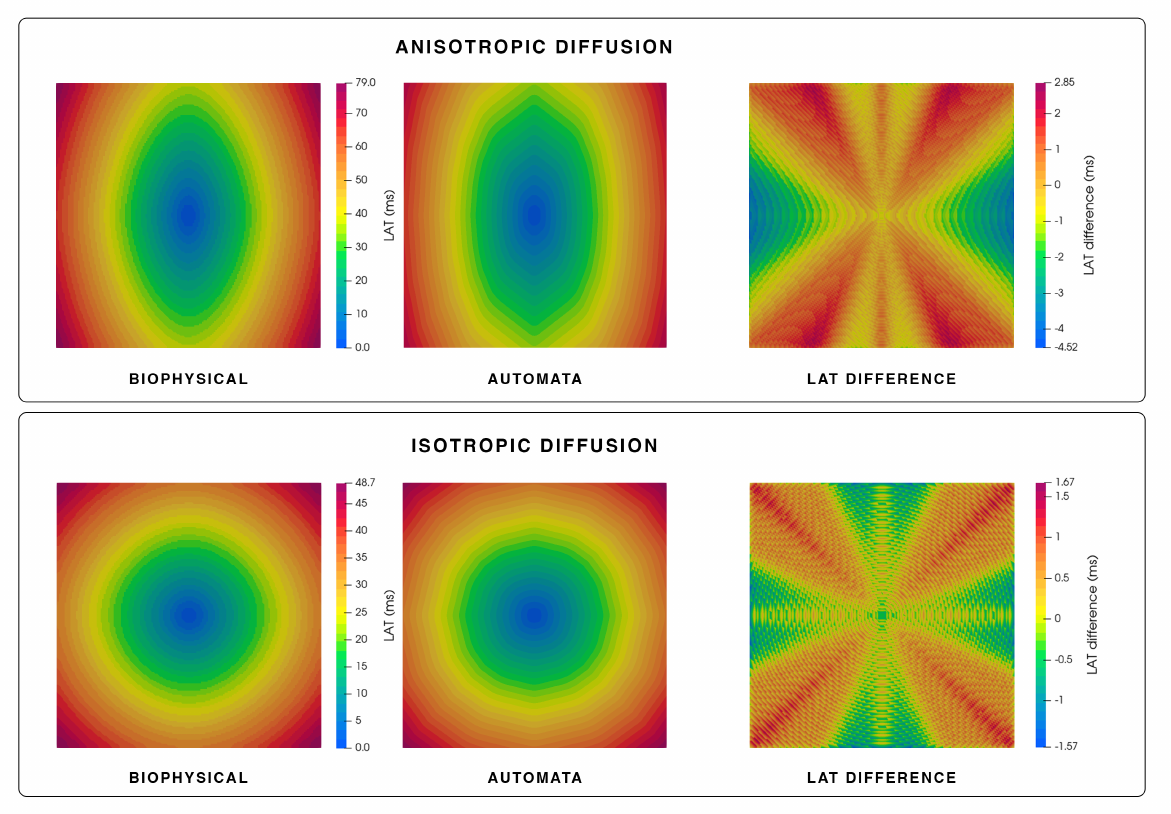
Figure 5. Comparison of electrical propagation in a 3D slab of tissue for biophysical and CA models. The maps in the first and second columns represent the local activation maps in milliseconds produced by a single stimulus in the center of the model. Third row shows the difference between biophysical and CA simulations. Mesh is 5 × 5 cm in size and has an element resolution of 300 µ